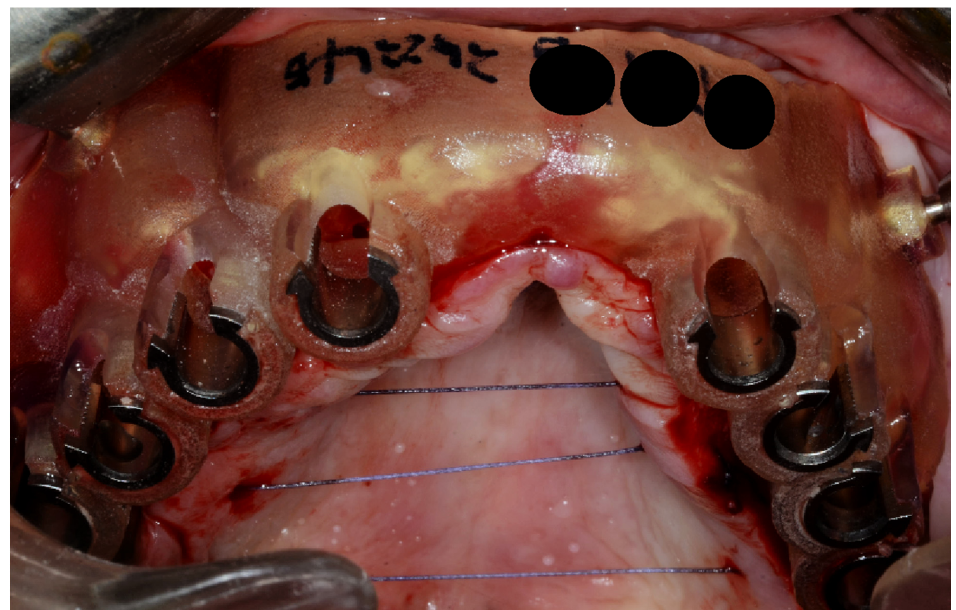
Figure 3 Surgical guide for pilot-guide implant surgery; bone-supported. Figure 3. Surgical guide for pilot-guide implant surgery; bone-supported.